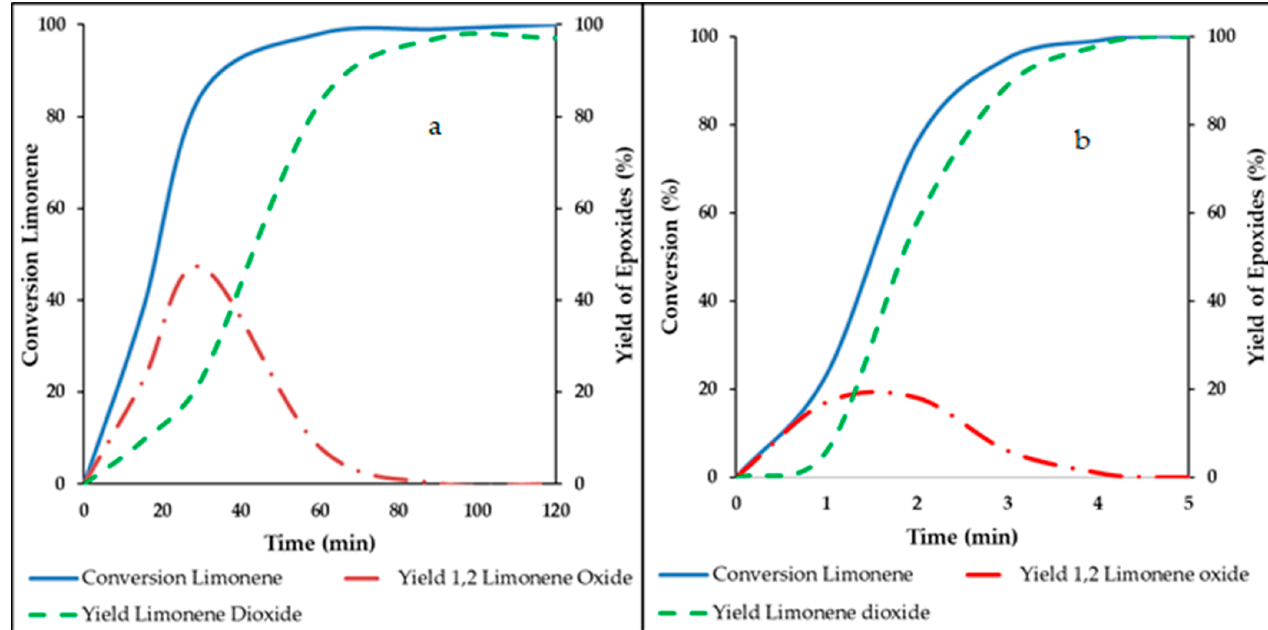
Figure 1. Comparison of limonene epoxidation results: ( a ) in absence of ultrasound; ( b ) under ultrasound. Reprinted with permission from Ref. [42]. Copyright 2018 American Chemical